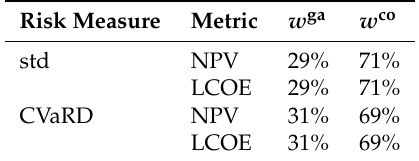
Table 5. The composition of minimum risk portfolios in the 30-year portfolio selection problem. The two-asset